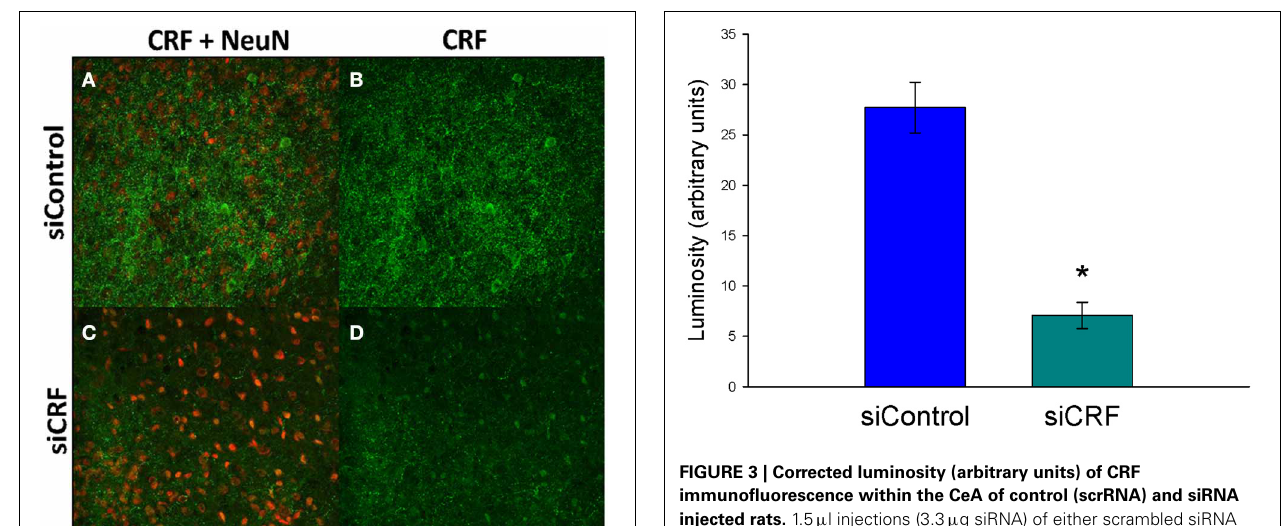
0 . 41; p = 0 . 75], duration of time spent in center [ F ( 3 , 50 ) = 0 . 36; p = 0 . 78] and rearing [ F ( 3 , 50 ) = 2 . 17; p = 0 . 10].